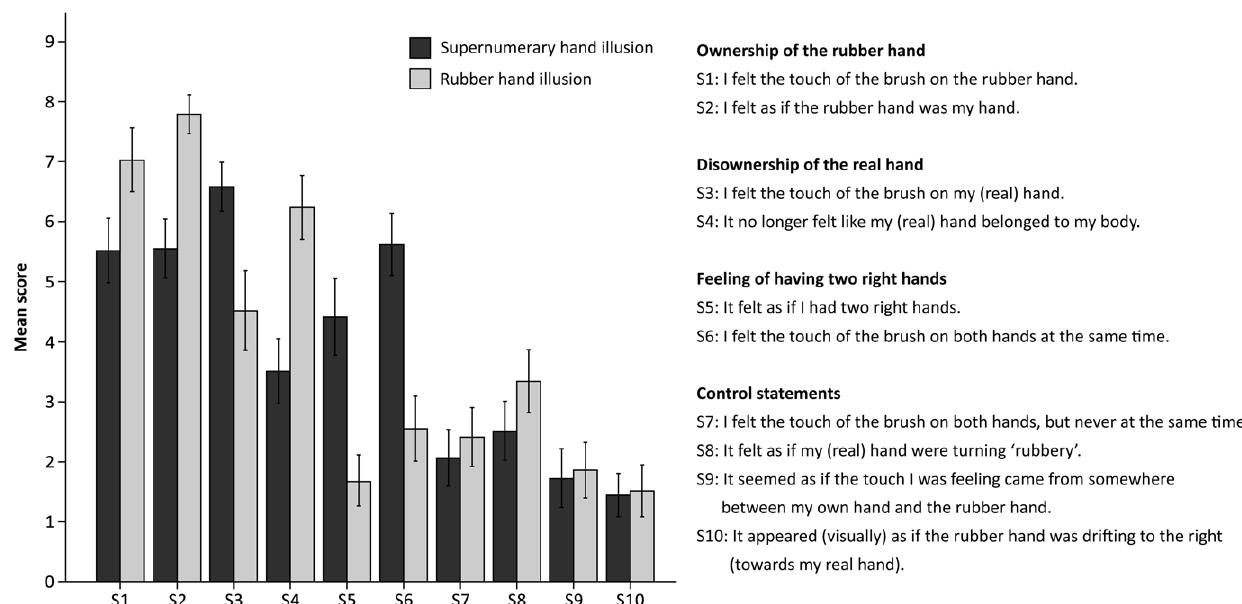
Figure 8. The unique qualities of the supernumerary hand illusion. Questionnaire data from experiment 5 demonstrating the differences between the supernumerary hand illusion and the traditional rubber hand illusion. During the supernumerary hand illusion, participants experienced significantly weaker rubber hand ownership (S1–S2) (p , 0.001), less real hand disownership (S3–S4) (p=0.001) and had a stronger feeling of having two right hands (S5–S6) (p , 0.001). The error bars represent the standard